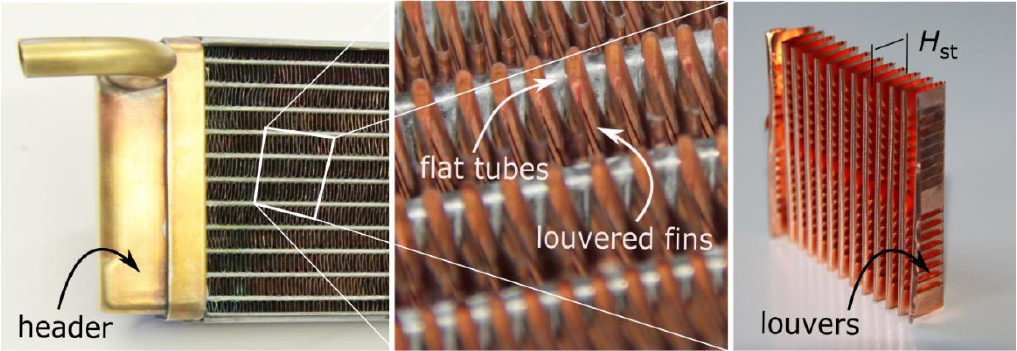
Figure 1. Air-to-water flat tube heat exchanger ( left ) with louvered fins between the tubes ( middle ); Details of a louvered fin package used between top and bottom sample plates ( right ) [18].